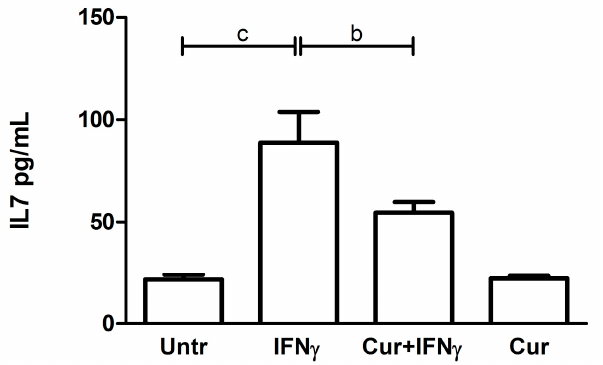
Figure 8. IL7 quantification after curcumin pre-treatment. The HT29 cell line was pre-incubated with curcumin (Cur) and, after 24 h, stimulated with IFN γ for an additional 48 h to evaluate the cytokine secretion. The histograms represent the concentration (pg/mL) of IL7 expressed as the mean ± SD of four replicates. Data were analyzed with one-way ANOVA using the Bonferroni post-test; (b: p < 0.01; c: p < 0.001).